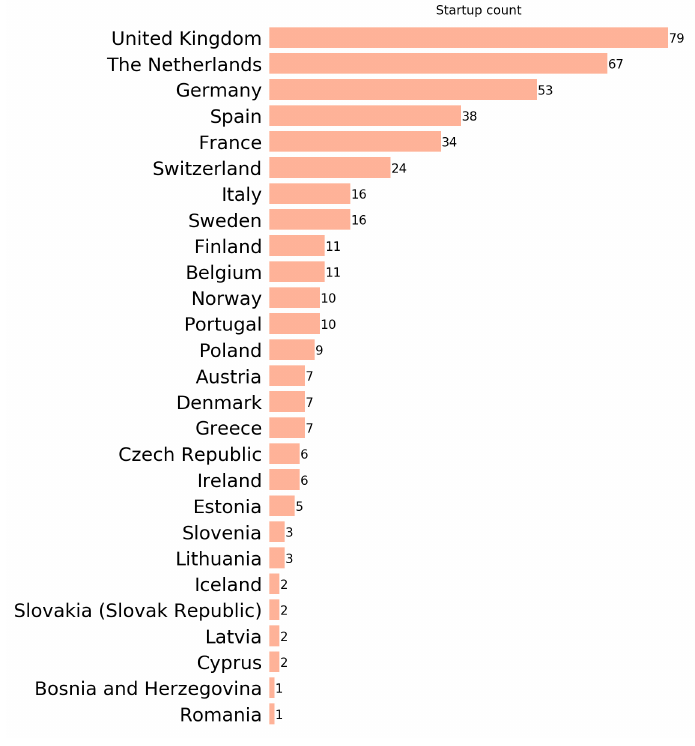
Figure 5. Founding countries (Head quarter), period